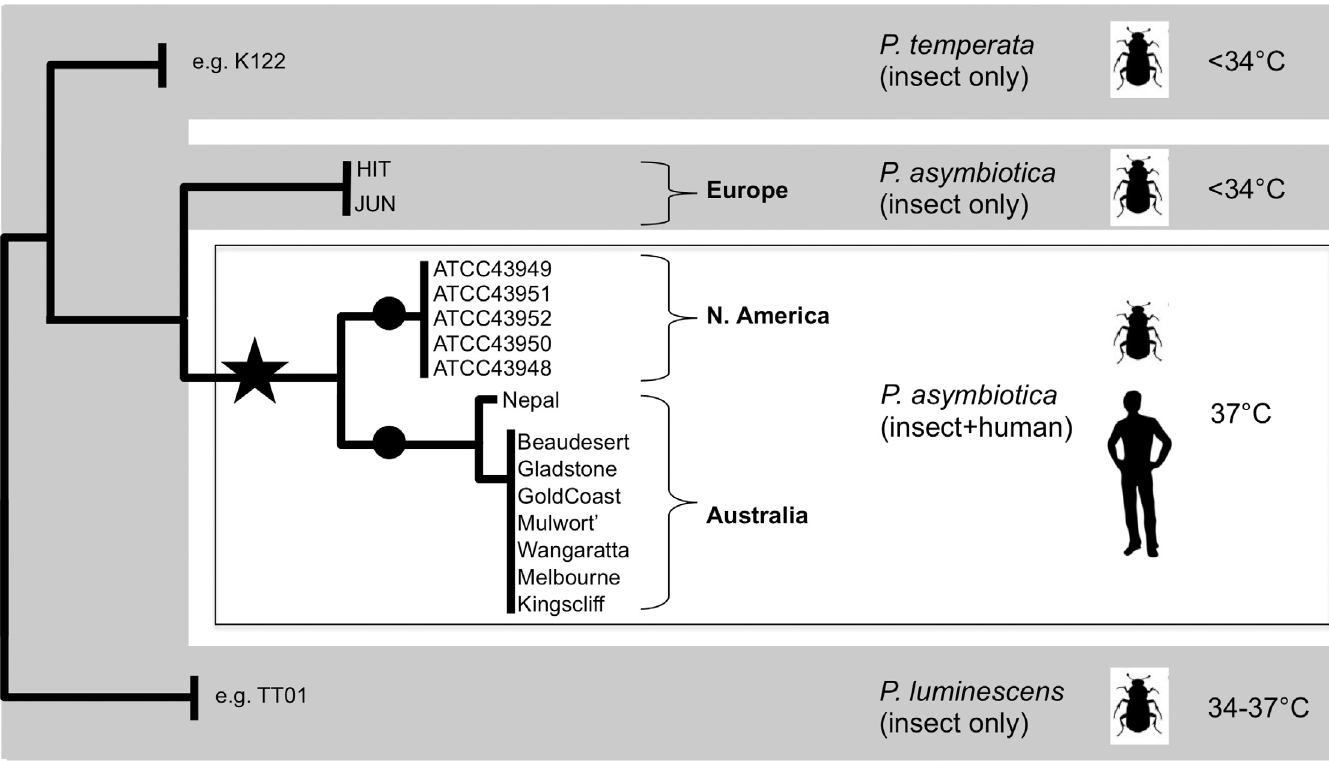
Fig 1. The genus Photorhabdus contains three predominant species. A stylized representation of a previous six gene MLST phylogeny ( adk , ghd , mdk , ndh , pgm and recA ) of Photorhabdus (adapted from [5]) is shown. The grey areas indicate species that consist of multiple strains, the majority of which are unable to grow above 34°C, with only a few P . luminescens strains capable of growth at temperatures up to 37°C. Example strains are P . luminescens TT01 and P . temperata K122 . The clinical strains adapted to 37°C are boxed. The stars and circles indicate the potential historical timing of temperature adaptation, which could have occurred ancestrally (star) or independently (circles) in different geographical